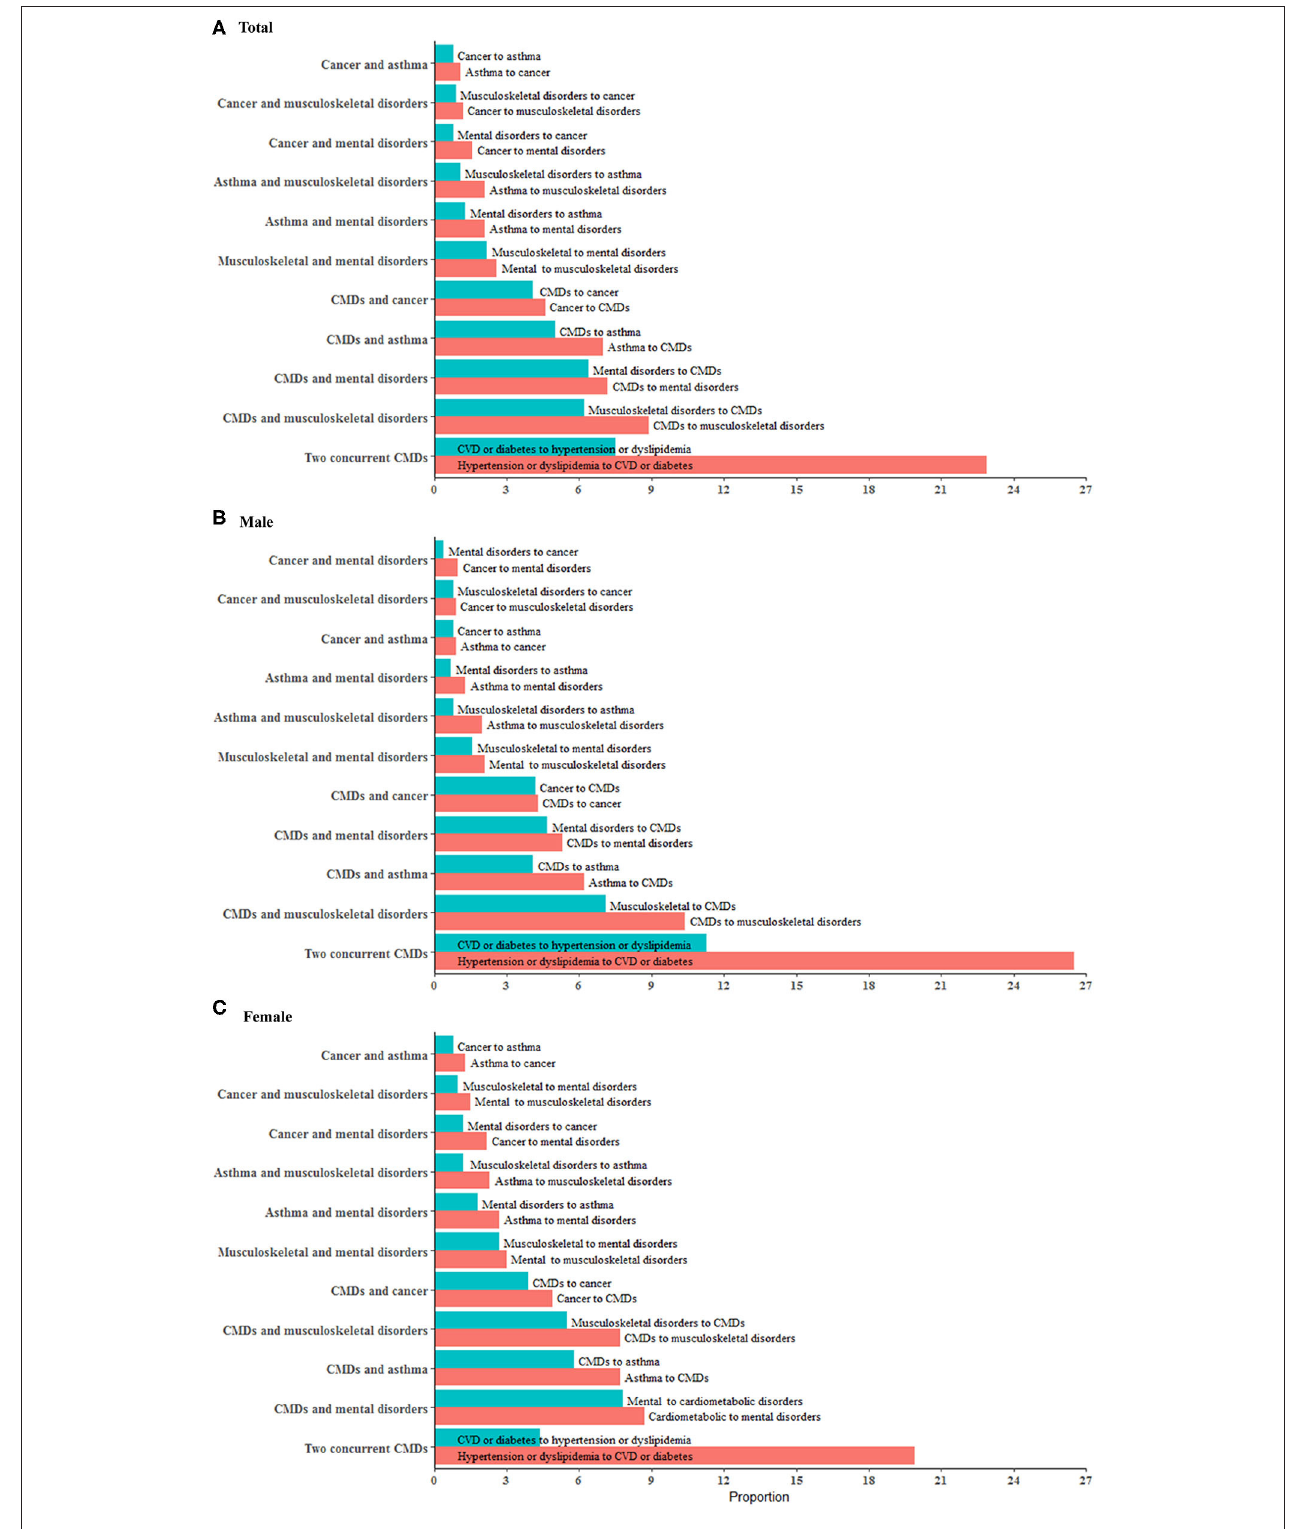
FIGURE 3 | Major multimorbidity patterns in middle-aged men and women. The multimorbidity patterns were examined using the combination and permutation of the first two chronic conditions in 12,753 participants (54.7% women). (A–C) show major multimorbidity patterns of two conditions in total population, men and